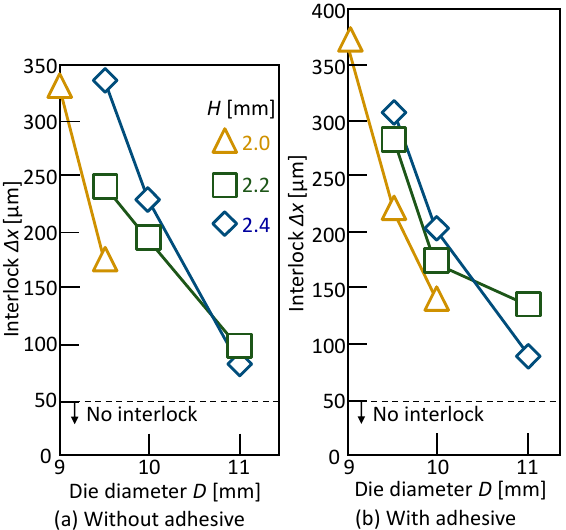
Figure 12. Joining ranges ( a ) without and ( b ) with adhesive for L = 6 mm.